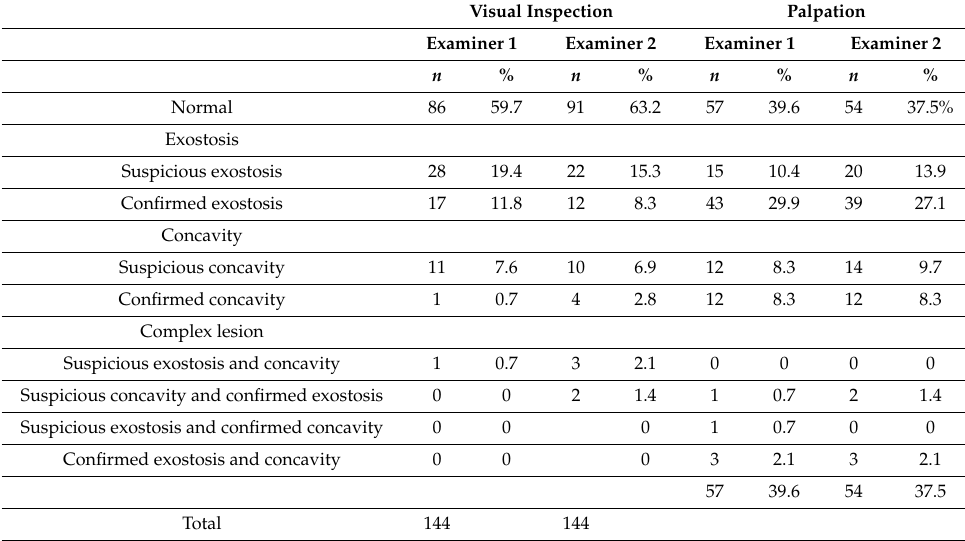
Table 5. Distribution of categories of lesions in mandible bones as detected by two examiners conducting visual inspection and